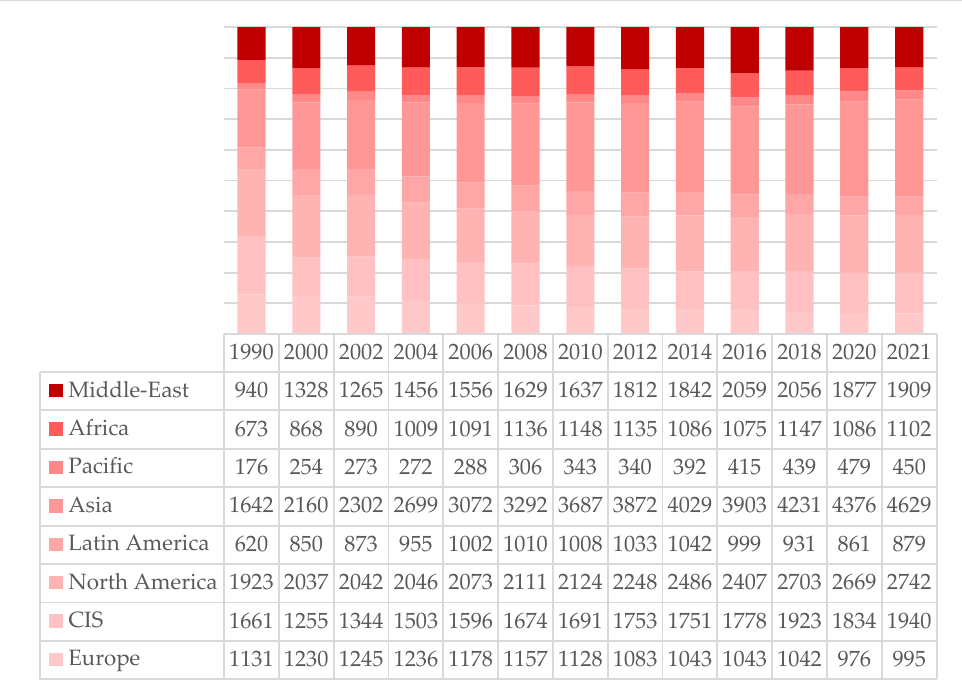
Figure 8. Total energy production by region for 1990; 2000–2020 (when analyzed in a 2-year period); 2021, Mtoe [29].